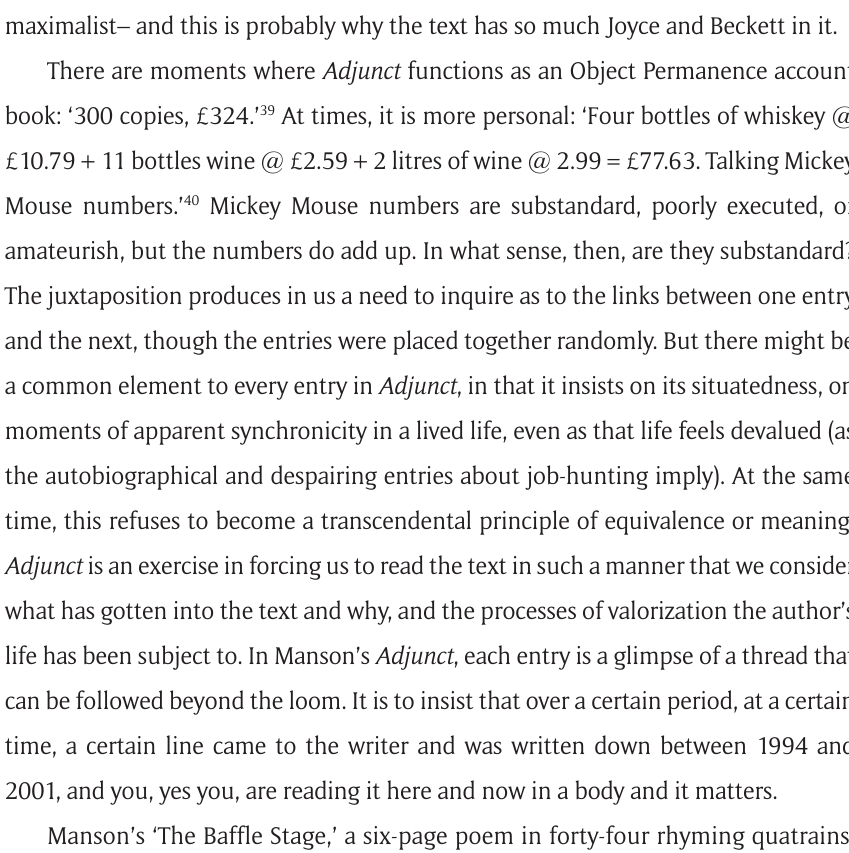
Mouse numbers.’ 40 Mickey Mouse numbers are substandard, poorly executed,